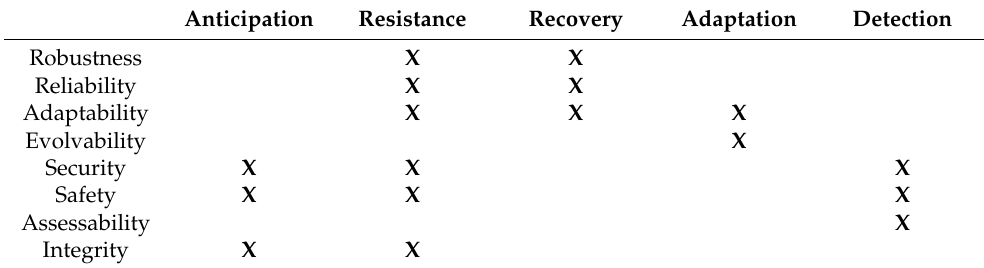
Table 3. Mapping of the mentioned attributes to the key actions. Anticipation Resistance Recovery Adaptation Detection